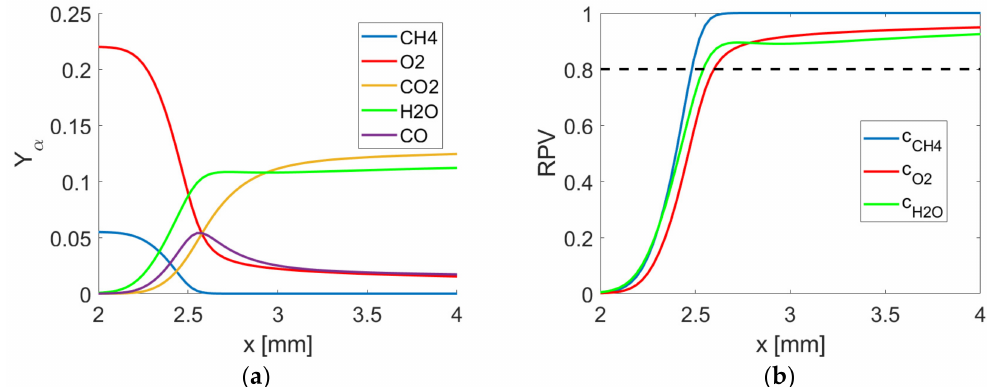
Figure 2. ( a ) Mass fractions of major species variations in the direction of flame propagation. ( b ) Reaction progress variable (RPV) based on CH 4 ,H 2 O,O 2 mass fractions versus axial position. Results are taken from laminar flame simulations of a stoichiometric methane-air flame.